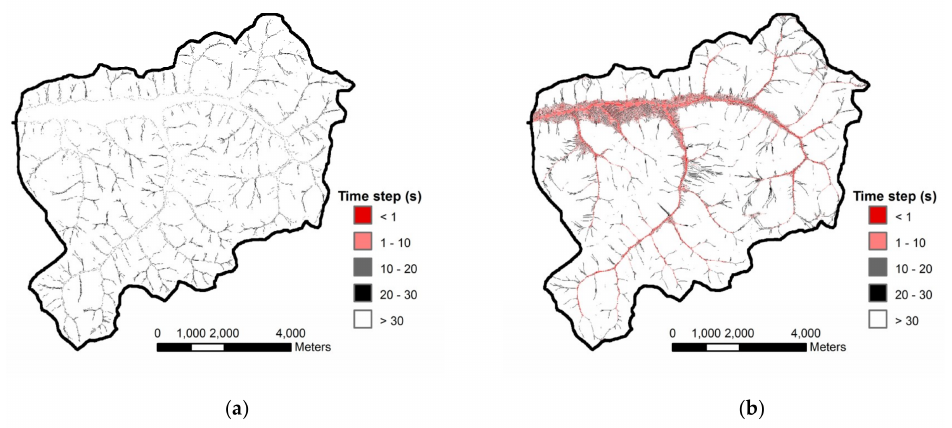
Figure 7. Distribution of the allowable time steps subject to the CFL condition during the simulation of the storm occurring on 16 August 1968, ( a ) 2nd hour, ( b ) 20th